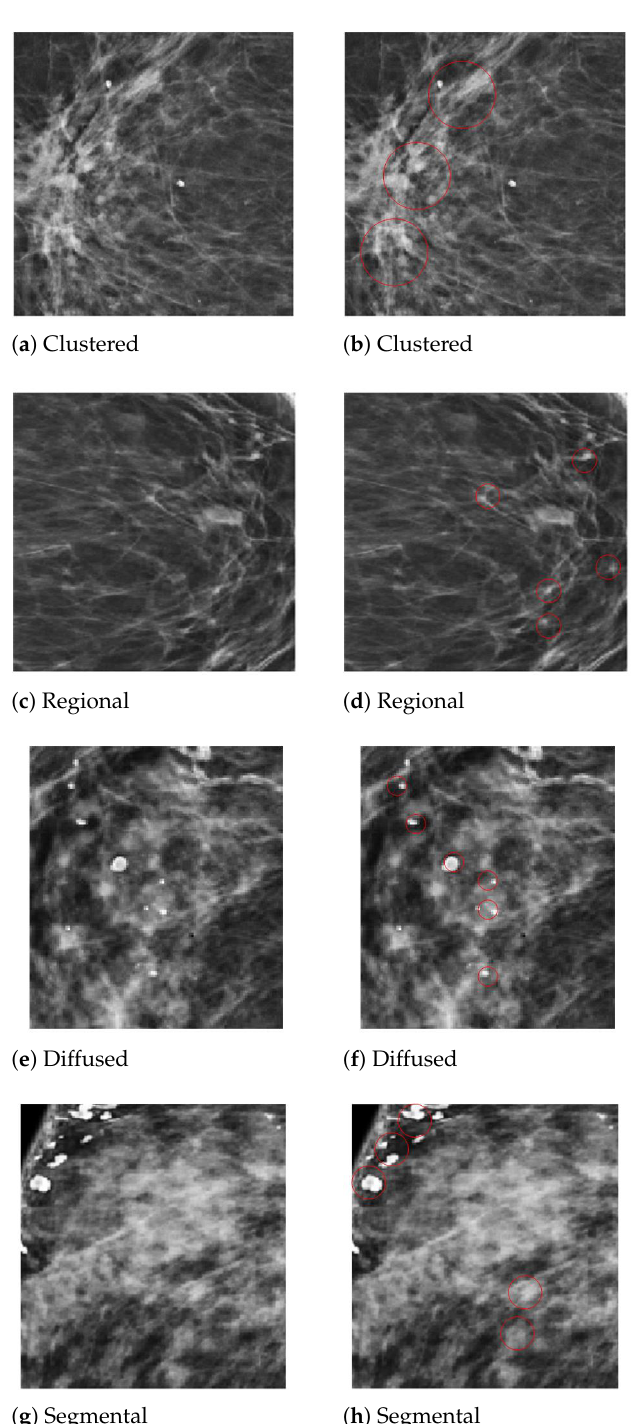
and pixel value percentages. P r is the pixel value percentage for red, P g for green, and P b for blue.